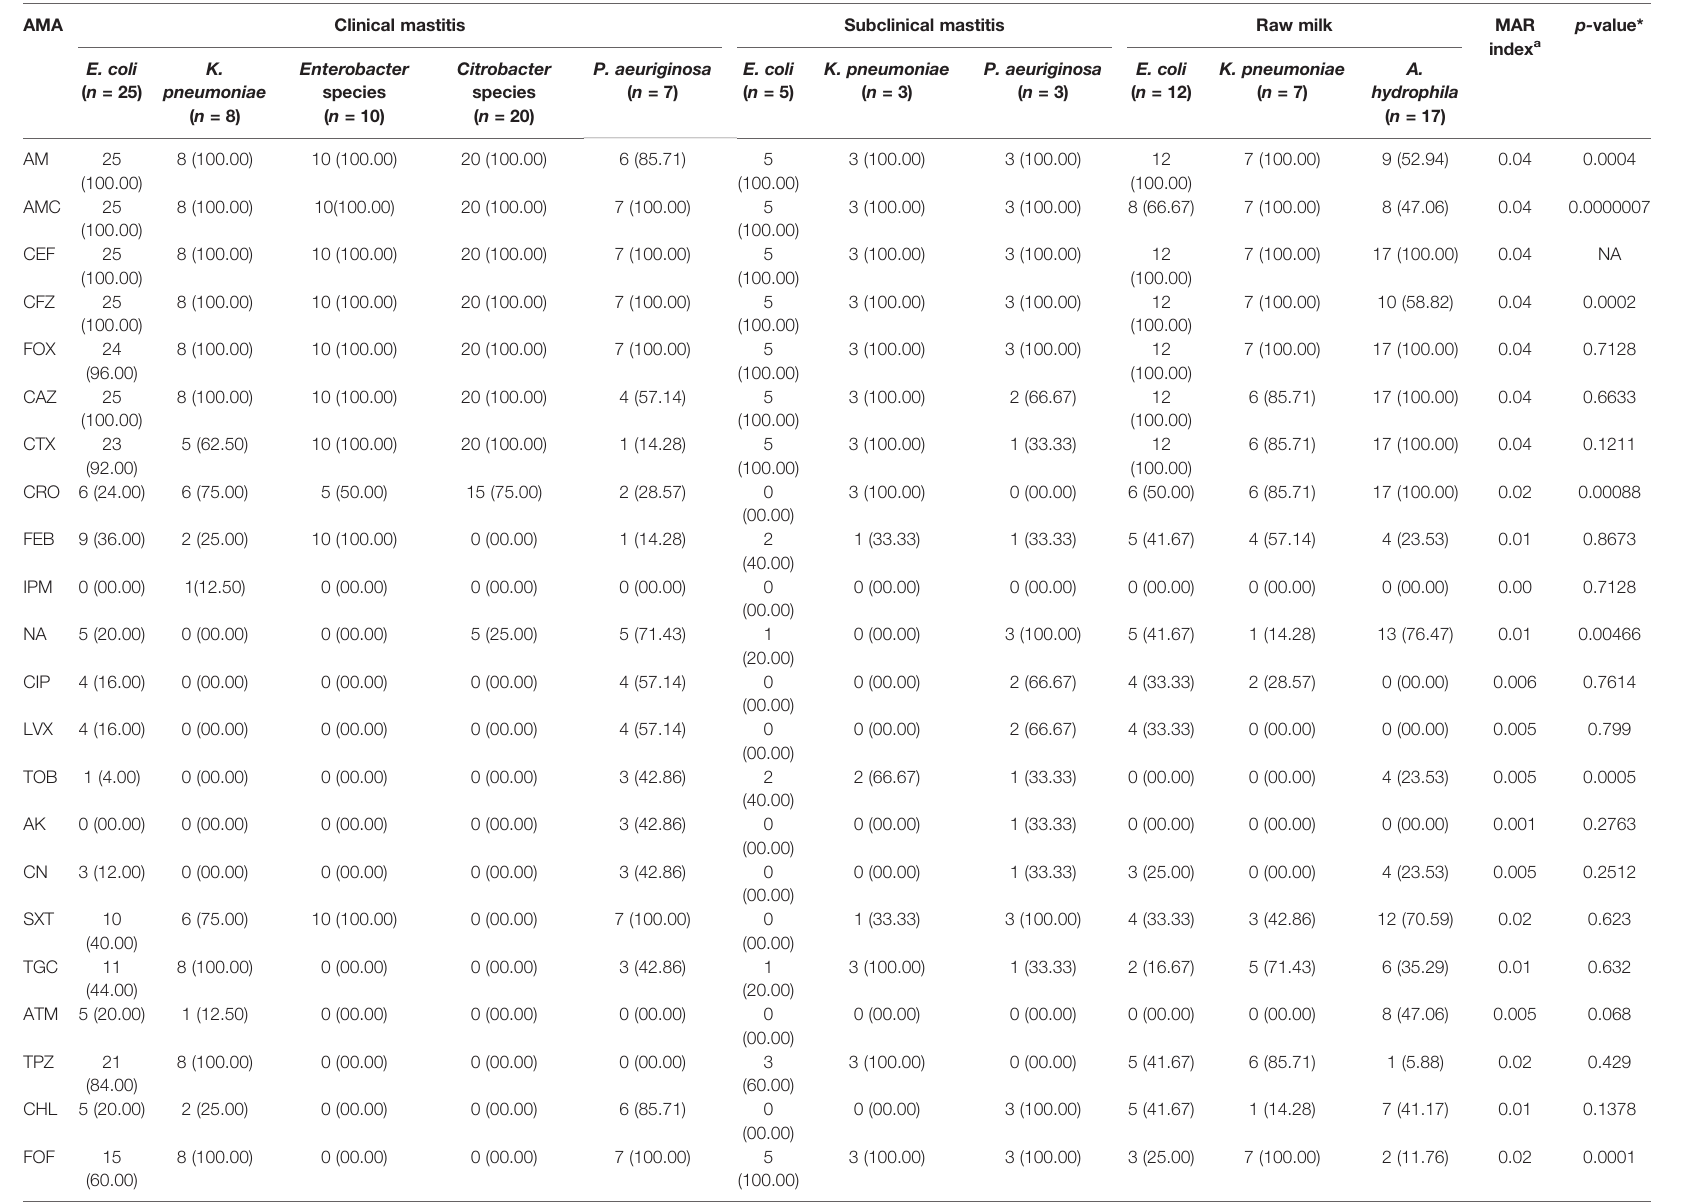
TABLE 1 | Resistance rates of 117 Gram-negative bacteria from milk samples against the tested antimicrobial agents and the overall multiple antibiotic resistance (MAR) index. AMA Clinical